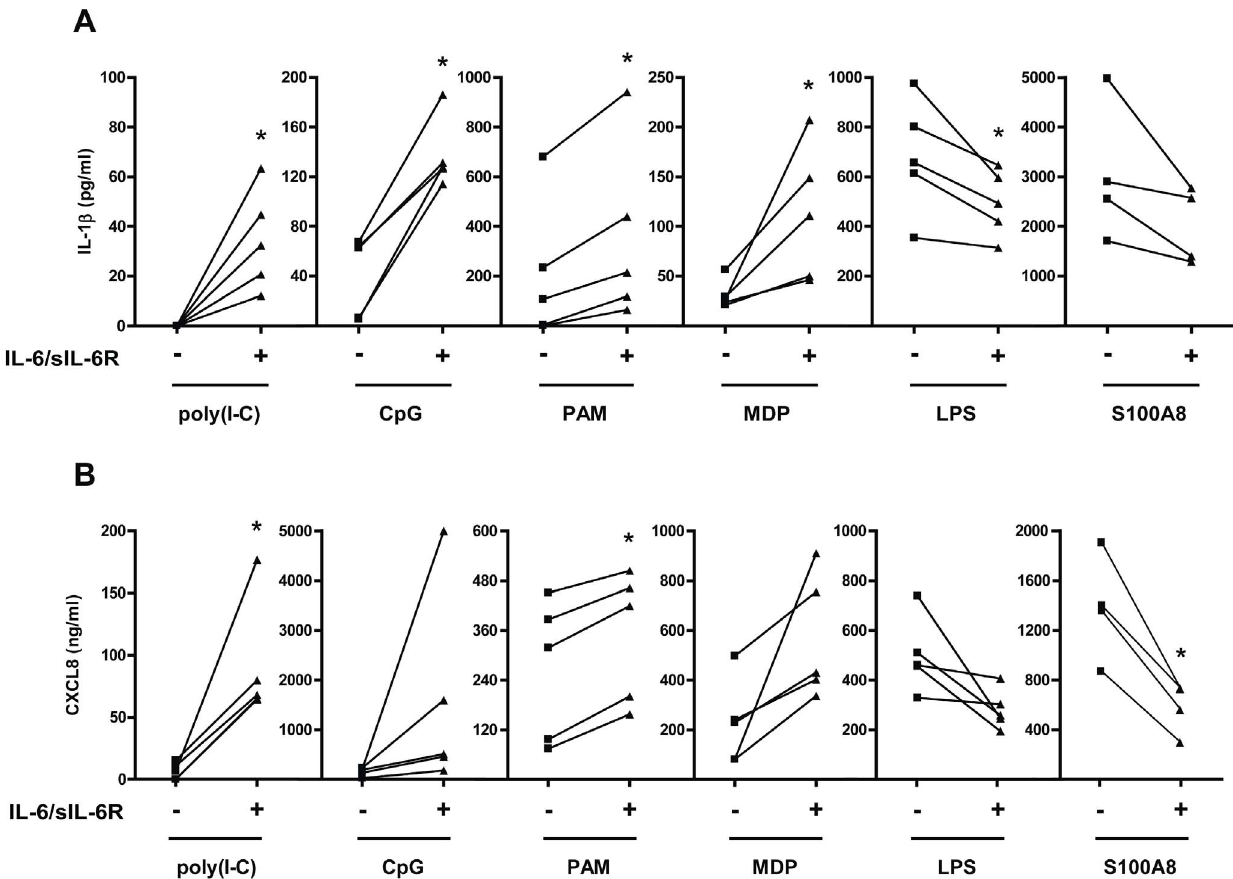
Figure 2. Exposure to IL-6 affects the production of inflammatory cytokines and chemokines in human PBMCs in response to TLR ligands. Human PBMCs were pre-exposed to IL-6/sIL-6R for 1 hour. Cells were then stimulated with poly(I-C) (20 m g/ml), CpG (5 m g/ml), PAM (200 ng/ml), MDP (10 m g/ml), LPS (10 ng/ml), S100A8 (5 m g/ml) for 18 hours. IL-1 b ( A ) and CXCL8 ( B ) levels were measured by ELISA. *p , 0.05 for values from IL-6/sIL-6R-stimulated compared with NT